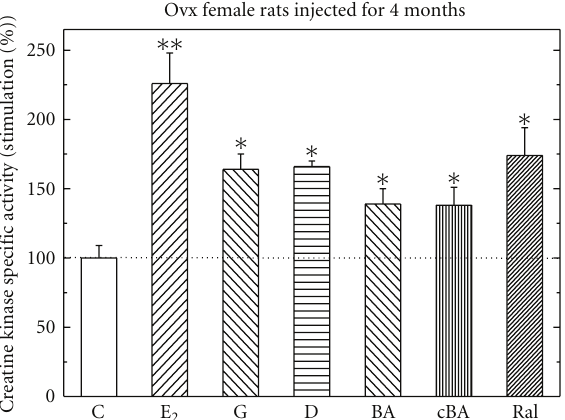
Figure 4: Stimulation of creatine kinase (CK) specific activity by di ff erent estrogenic compounds in pituitary from ovariectomized female rats, injected daily for 4 months. Rats were treated and assayed for CK activity as described in Section 2. Results are means ± SEM for n = 5–10 rats/group. Experimental means compared to control means: ∗ P < . 05 and ∗∗ P < . 01. Basal activity in the pituitary was 0 . 87 + 0 . 17 μ mol/min/mg protein.